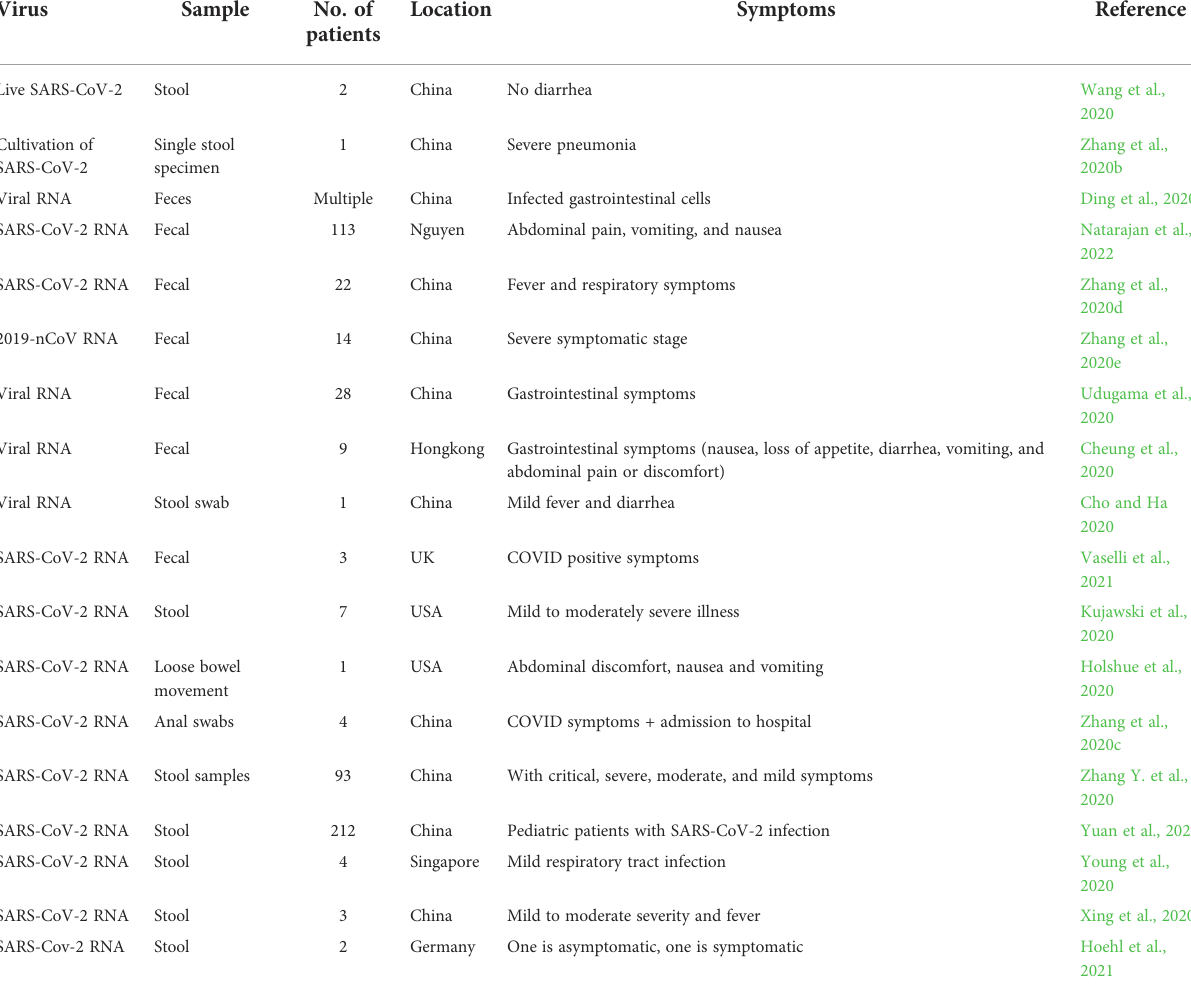
TABLE 1 Worldwide studies on the replication and infection of SARS-COV-2 in stool and fecal samples.